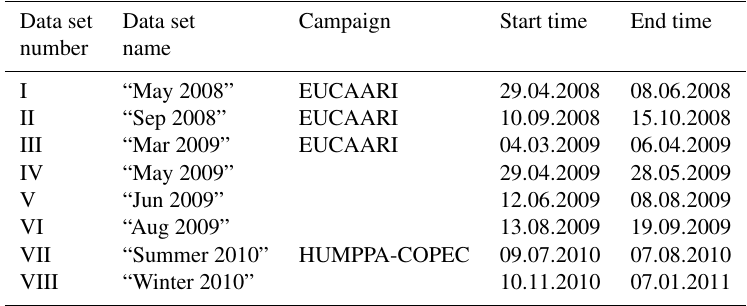
Table 1. Data sets used in this study and their time frames (dd.mm.yyyy). Data set